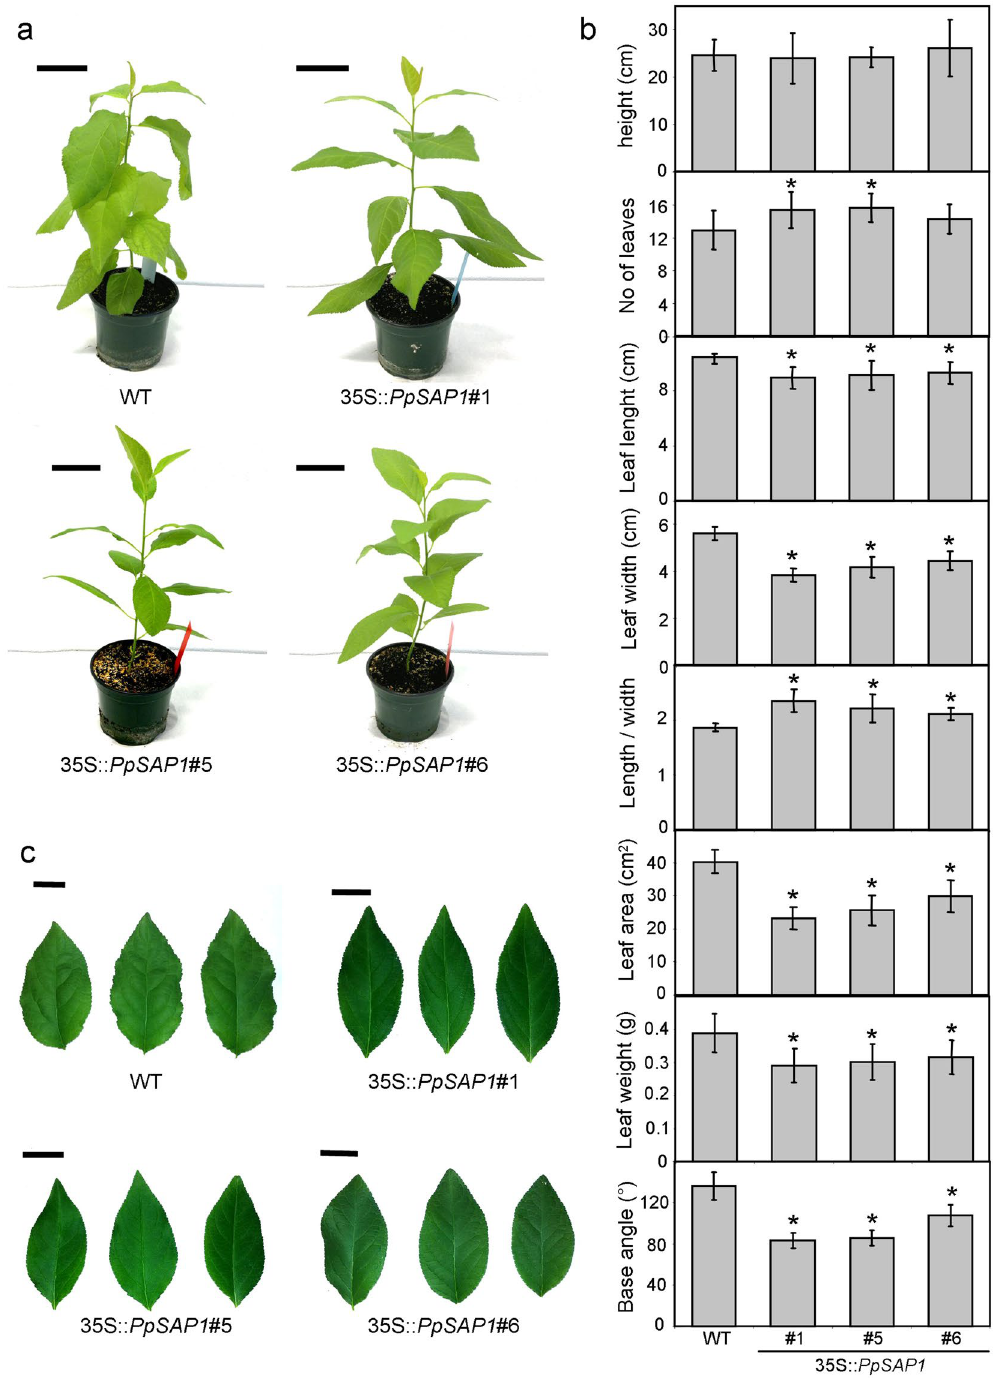
Figure 7. Plant anatomy and leaf morphology in plum overexpressing PpSAP1 . Two month old plants of wild type (WT) and transgenic lines 35S:: PpSAP1 #1, #5 and #6 are shown ( a ); scale bar, 5 cm. In ( b ), different whole plant and leaf shape parameters of two month old plants are shown. Data are means from twelve different plants, with error bars representing standard deviation. An asterisk indicates significant difference with the control at a confidence level of 95%. Photographic images of detached leaves are shown ( c ); scale bar, 2.5